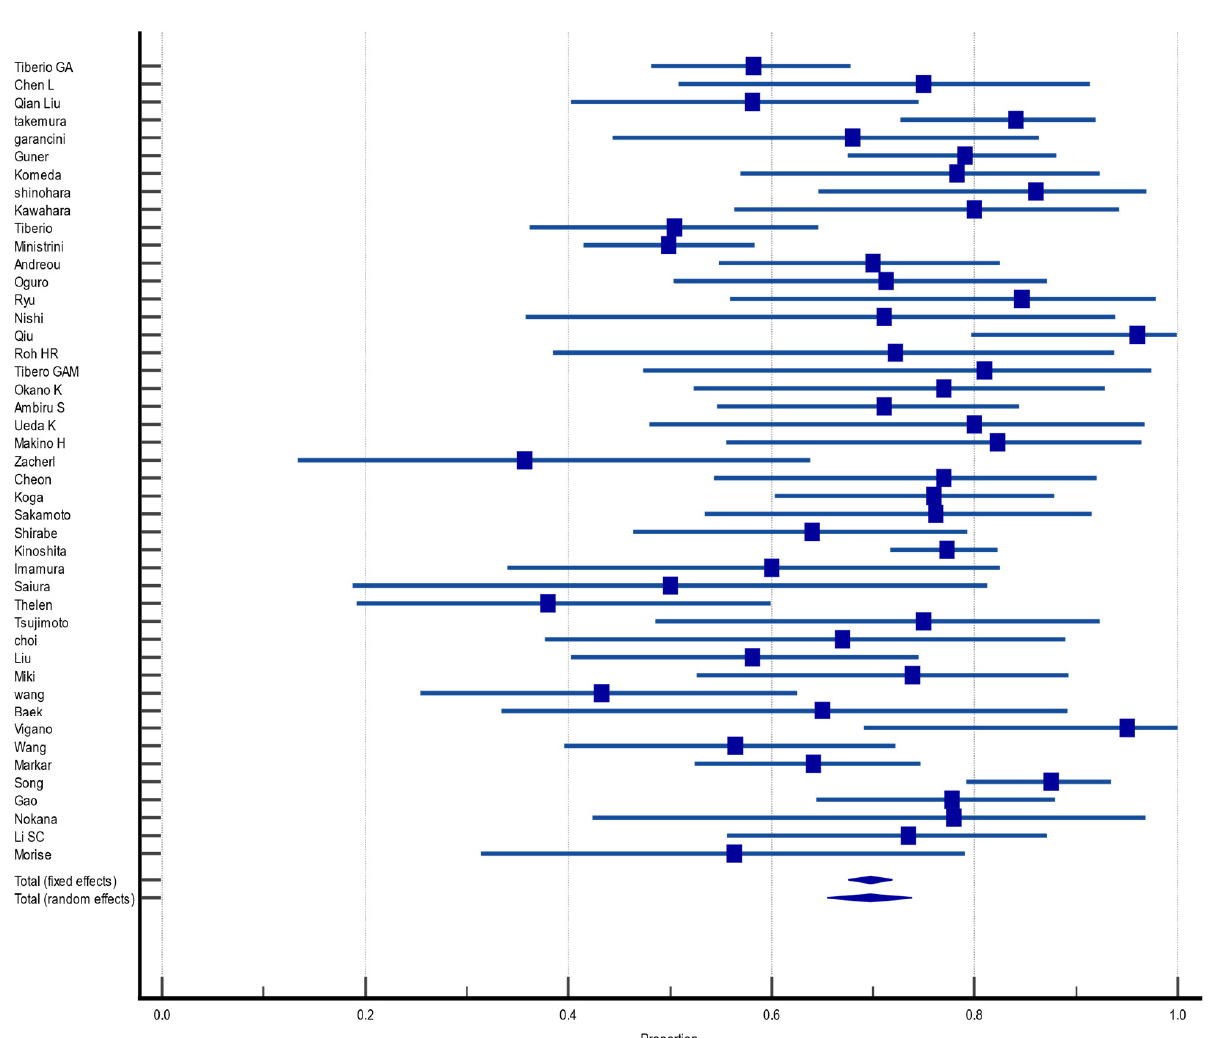
Figure 2. Forest plot of overall survival at 1 year after hepatectomy for gastric cancer liver metastasis (GCLM). Description of the proportion and confidence intervals at 95% in the studies that reported 1-year overall survival.